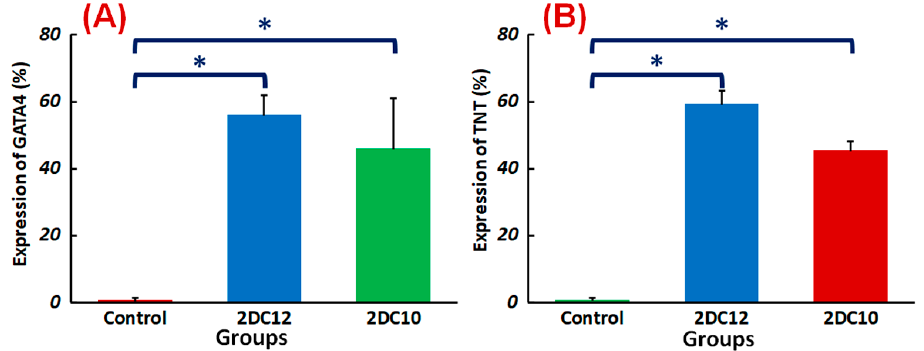
Figure 9. Differentiation of rMSCs encapsulated Alg-GO hydrogels: quantified expressions of ( A ) GATA4 (%) and ( B ) TNT (%), measured after two weeks of culture ( n = 3) (* p < 0.05).